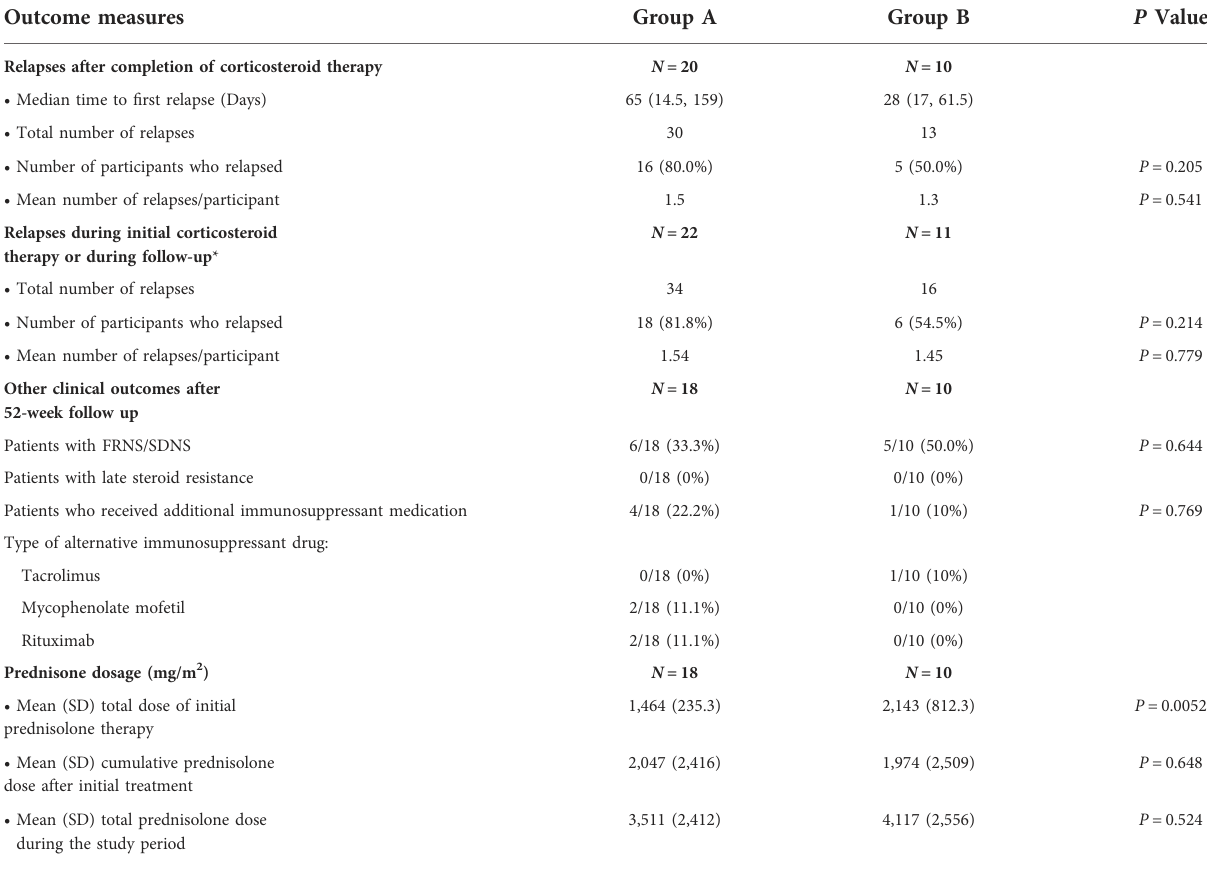
TABLE 3 Primary and secondary